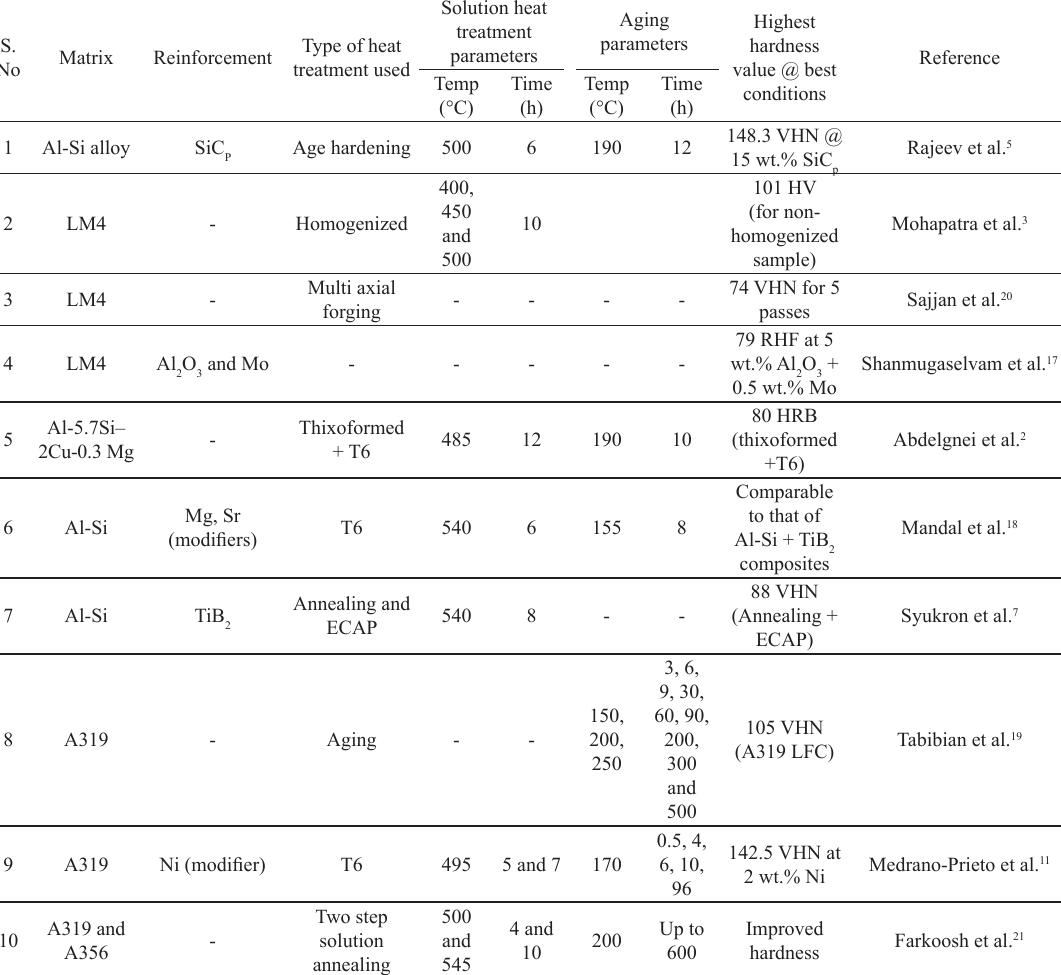
Table 1. Effect of various heat treatment parameters and reinforcements on the hardness of Al-Si alloys.